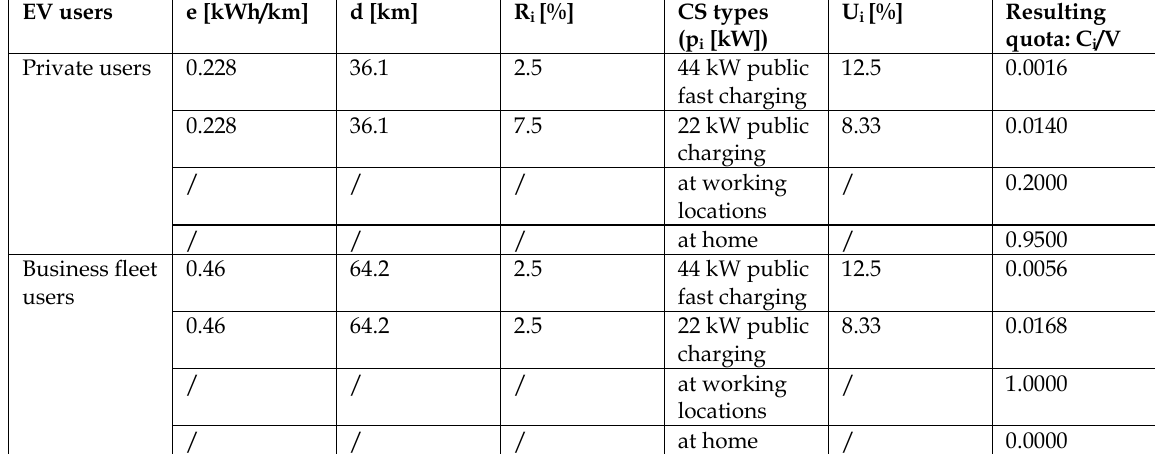
Table 2. Parameters and resulting quotas used for different EV users and CS types in the baseline